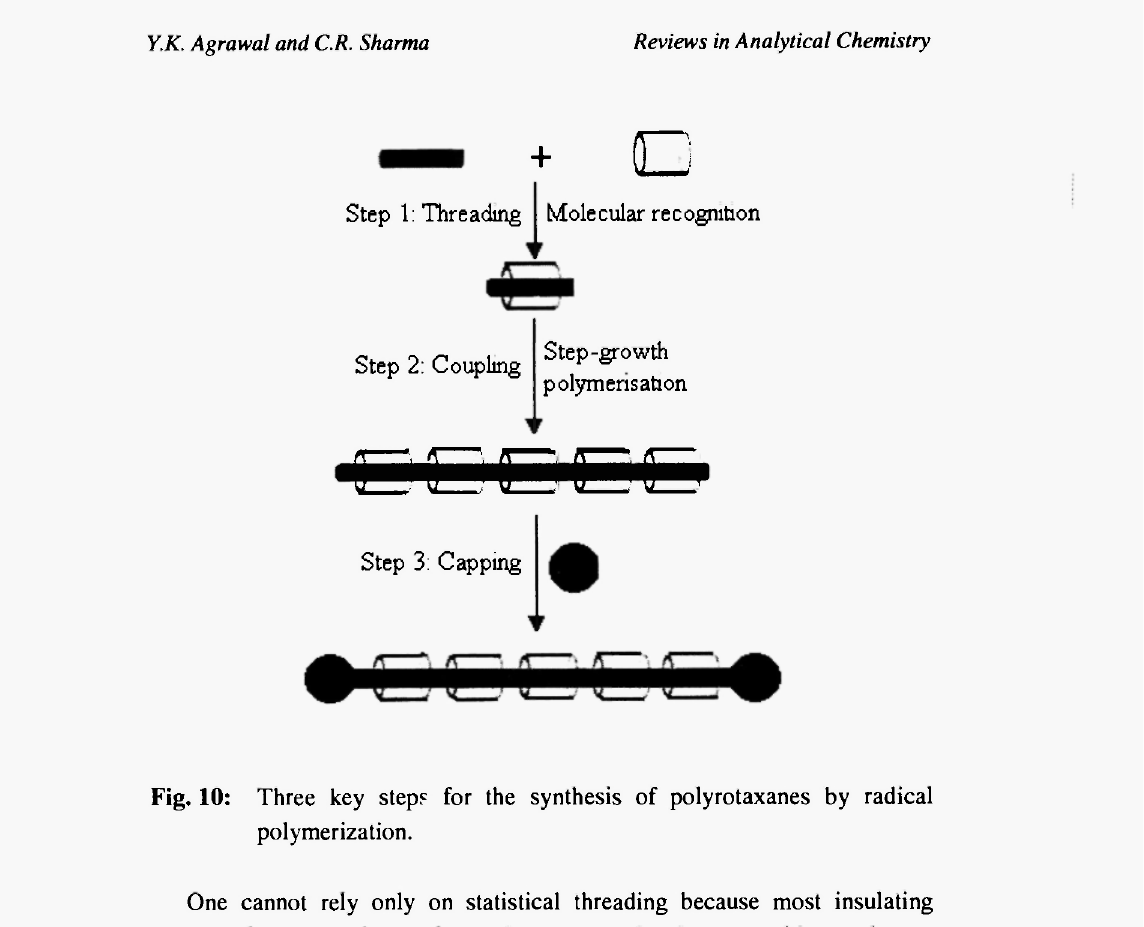
Fig. 10: Three key step? for the synthesis of polyrotaxanes by radical